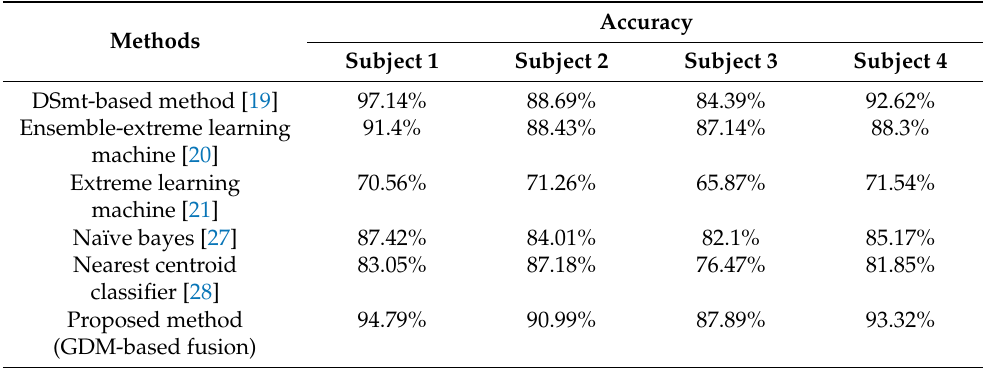
Table 4. Comparison with some state-of-the-art HAR approaches based on UCI OPPORTU- NITY